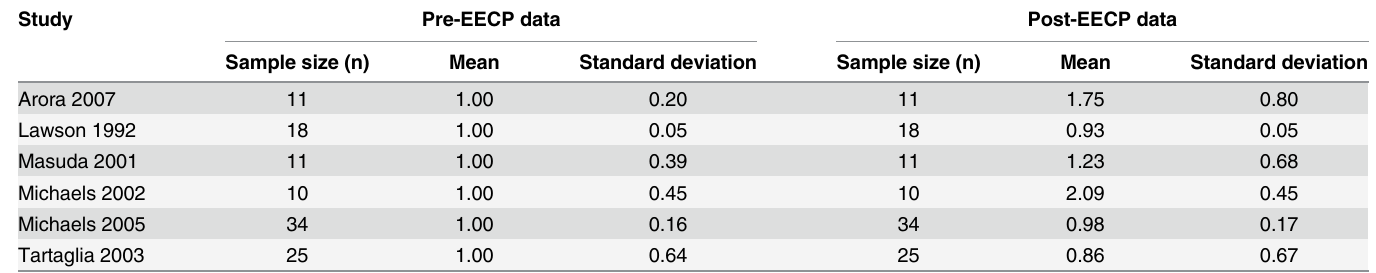
Table 3. Myocardial Perfusion Results from Included